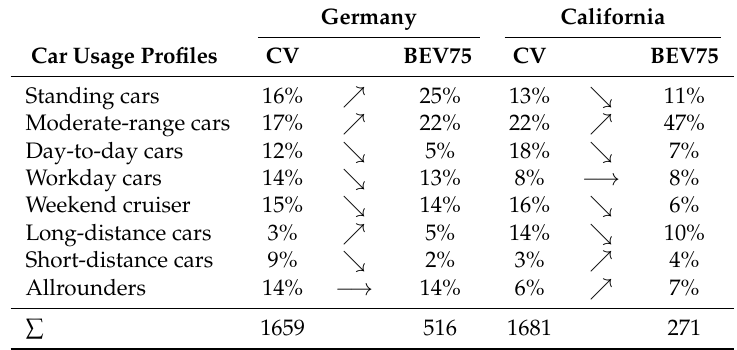
Table 3. Comparison of conventional (CV) and electric vehicles (BEV75) in Germany and California.